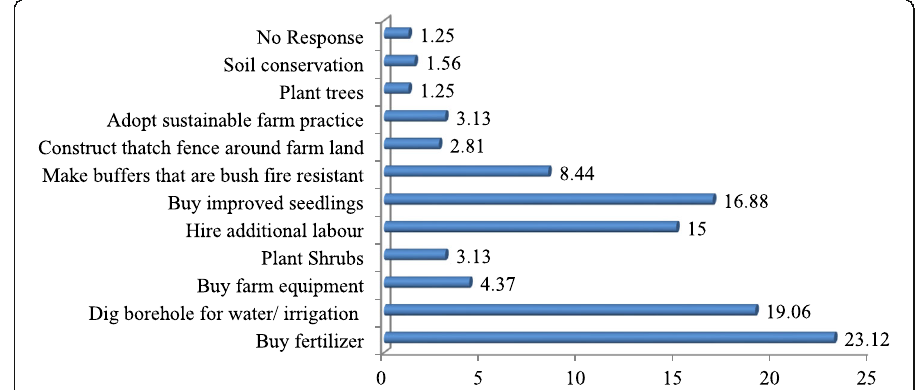
Fig. 6 Purpose for which Credit was sought by Household by Proportion (%). Source: Abraham and Fonta